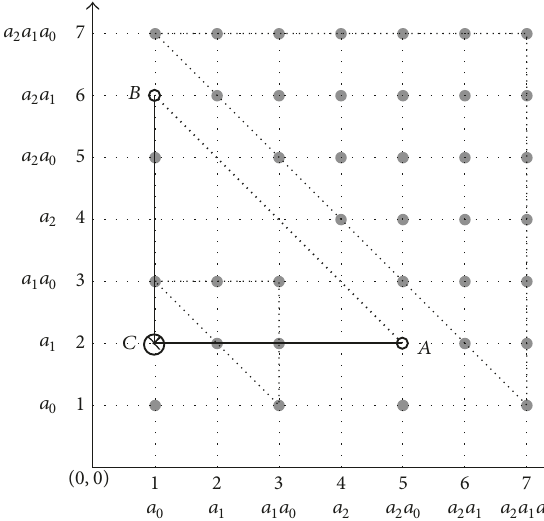
Figure 4: Diagonal optimization for